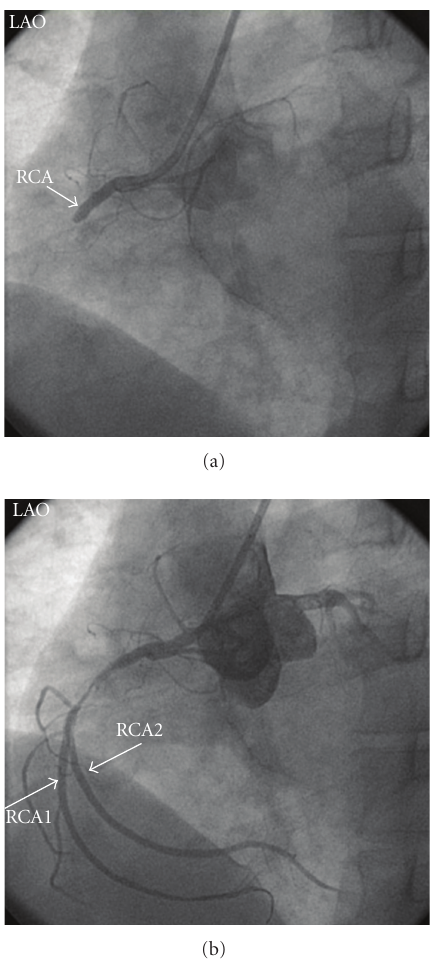
Figure 1: (a) LAO view of the totally occluded proximal RCA before percutaneous coronary intervention. (b) After predilatation with sprinter balloon, atypical double RCA was appeared (LAO: Left anterior oblique, RCA: Right coronary artery).